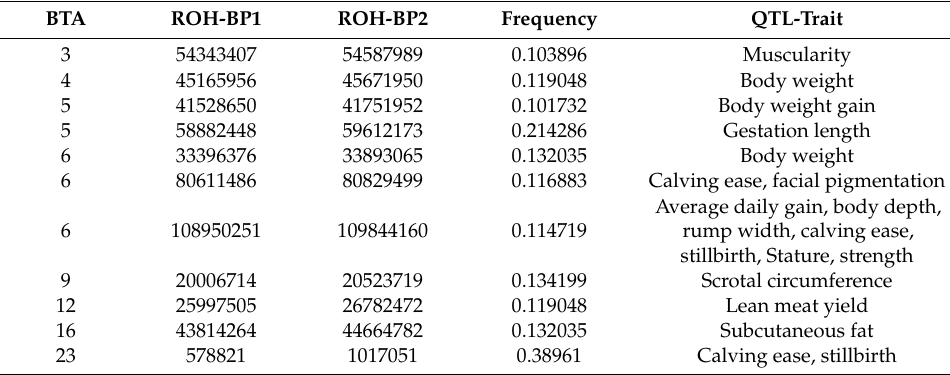
Figure 2. Distribution characteristics of ROH on chromosomes in Chinese Wagyu beef cattle. The horizontal axis is the single nucleotide polymorphism (SNP) position, which is ordered by the physical location of the genome; the vertical axis is the ROH frequency at this SNP. The horizontal line in the graph is where the ROH frequency equals 10%. Table 1. Summary of the identified ROHs and their overlapping candidate quantitative trait loci (QTLs) and related traits. The consensus ROH across the population were sorted by the frequency of ROH, and only ROH regions overlapped with QTLs (frequency exceeding 10%) were listed.